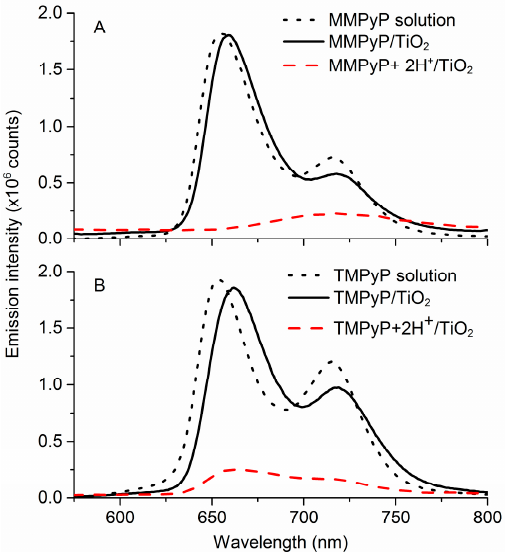
Figure 3. Emission spectra for ( A ) MMPyP/TiO 2 and ( B ) TMPyP/TiO 2 films before (solid black line), and after protonation (dashed red line). The corresponding spectra in ethanol solution are also shown (dotted black line).